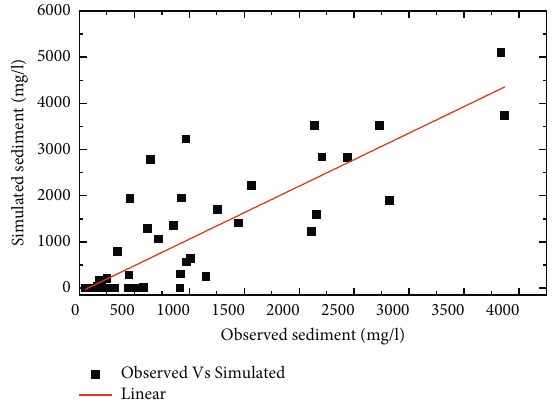
Figure 8: Observed versus simulated sediment scatter plot. Table 5: Average observe and simulated sediment during calibration and validation.